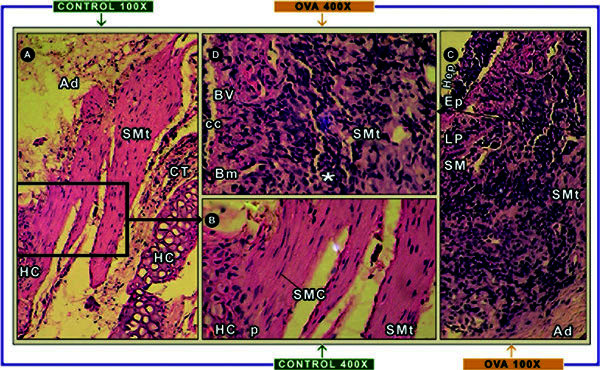
Airway smooth muscle histologic studies from OVA-sensitized and
control rats. The panels (A) and (B) represent the typical
tracheal tissue of the CONTROL rats group showing a thin layer of smooth
muscle (SMt) located between the edges of the hyaline cartilage ring
(HC) and it is enclosed by connective tissue (CT) with the adventitia.
The SM is bound to perichondrial tissue (p) through bundles of smooth
muscle cells (SMC). These SMC cells have elongated shape, eosinophilic
cytoplasm, and basophilic nucleus. The panels (C) and (D) represent the
tracheal wall of OVA rats, having a characteristic layered arrangement
of the trachea, because the epithelium (Hep) is thickened with
hyperplasia of caliciform cells (mL), basal membrane (Bm), lamina propia
(LP), and tunic submucosa (SM). Increased cellular connective tissue and
mononuclear cell infiltration (*), and formation of blood vessels
(BV), are shown. In the layer of SM an inflammatory infiltrate around
the SMC is also observed. Sections were stained with hematoxylin &
eosin. Magnification: × 100 (A, C) and × 400 (B, D).